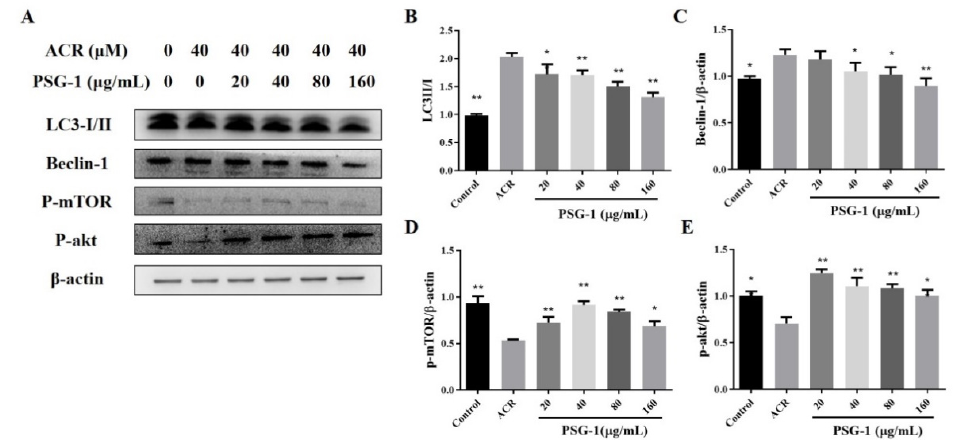
Figure 4. PSG-1-regulated, acrolein-induced autophagy-related proteins. ( A ) The protein levels of LC3, Beclin 1, p-mTOR, and p-akt. ( B – E ) Relative intensities of these proteins. Values are means ± SD ( n = 3), * p < 0.05, ** p < 0.01 compared with the acrolein group.